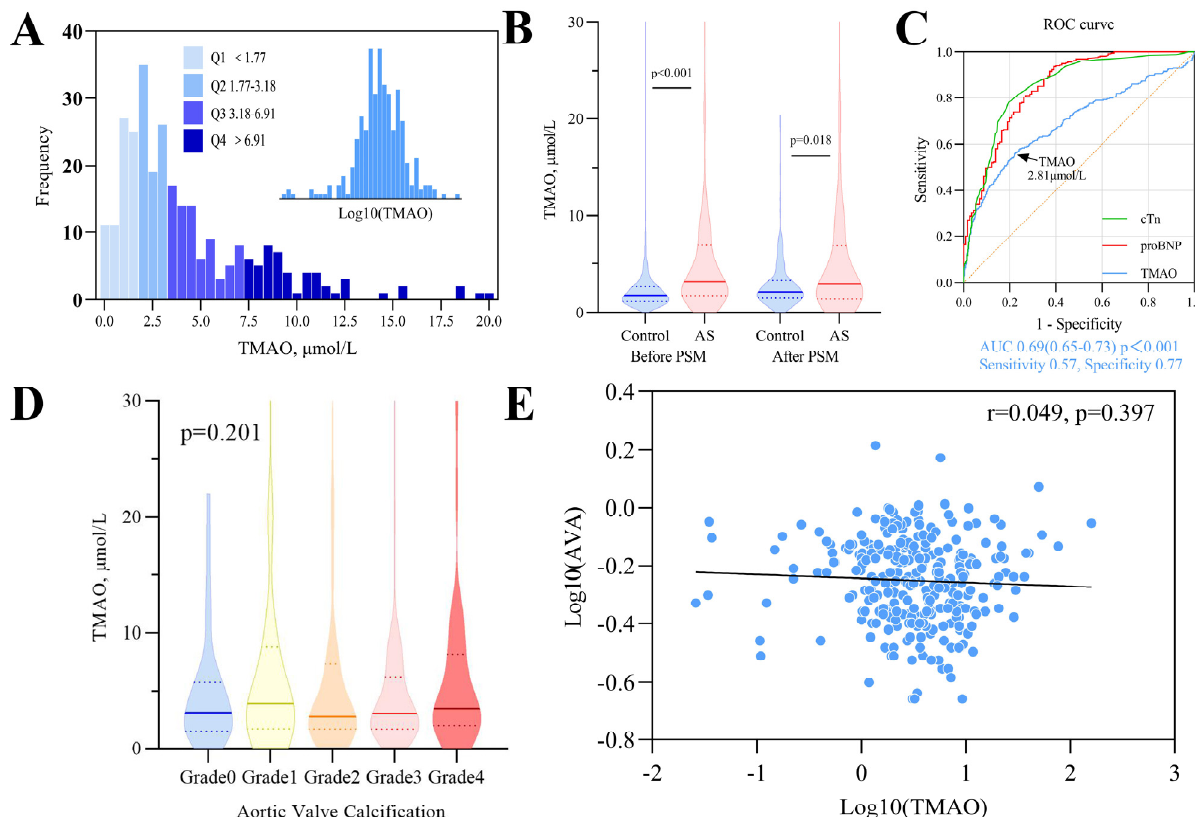
Figure 1. Serum TMAO levels in patients with or without aortic stenosis. ( A ) Frequency distribution histogram of serum TMAO levels in AS population, n = 299. ( B ) Violin plot of TMAO levels in patients with AS (n = 299) or without AS (control group, n = 711) before and after propensity matching (n = 126 in both groups). ( C ) TMAO achieved a receiver operating characteristic curve area under the curve of 0.69 with a best cut-off value of 2.81 μ mol/L. ( D ) Violin plot showing no significant difference of TMAO levels in different grades of aortic valve calcification (one-way ANOVA p = 0.201). Data are presented as violin plots with median (solid line) and quartiles (dotted line) in ( B , D ). ( E ) Correlation between TMAO and aortic valve area (AVA) in AS after common logarithm transformation. TMAO = Trimethylamine N-oxide; AS = aortic stenosis; cTn = cardiac troponin; proBNP = N-terminal prohormone of brain natriuretic peptide; AVA = aortic valve area.